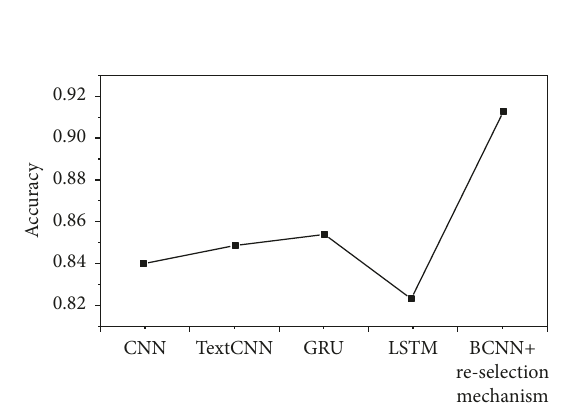
Figure 4: Experimental results (accuracy) of comparison between methods and classification algorithms in this section.